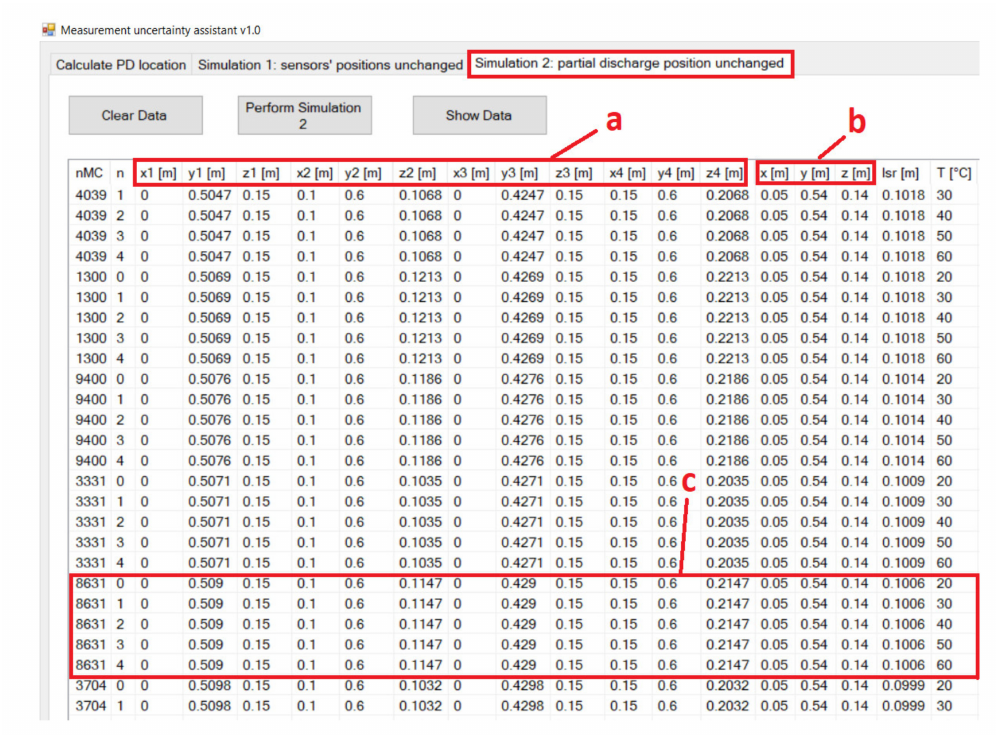
Figure 4. Presentation of the results of the second variant of the algorithm for simultaneous variations in input variables in the MUA software. ( a ) Sensors’ positions are randomized; ( b ) PD location remains unchanged; ( c ) the results of one-at-a-time oil temperature algorithm within the single MC